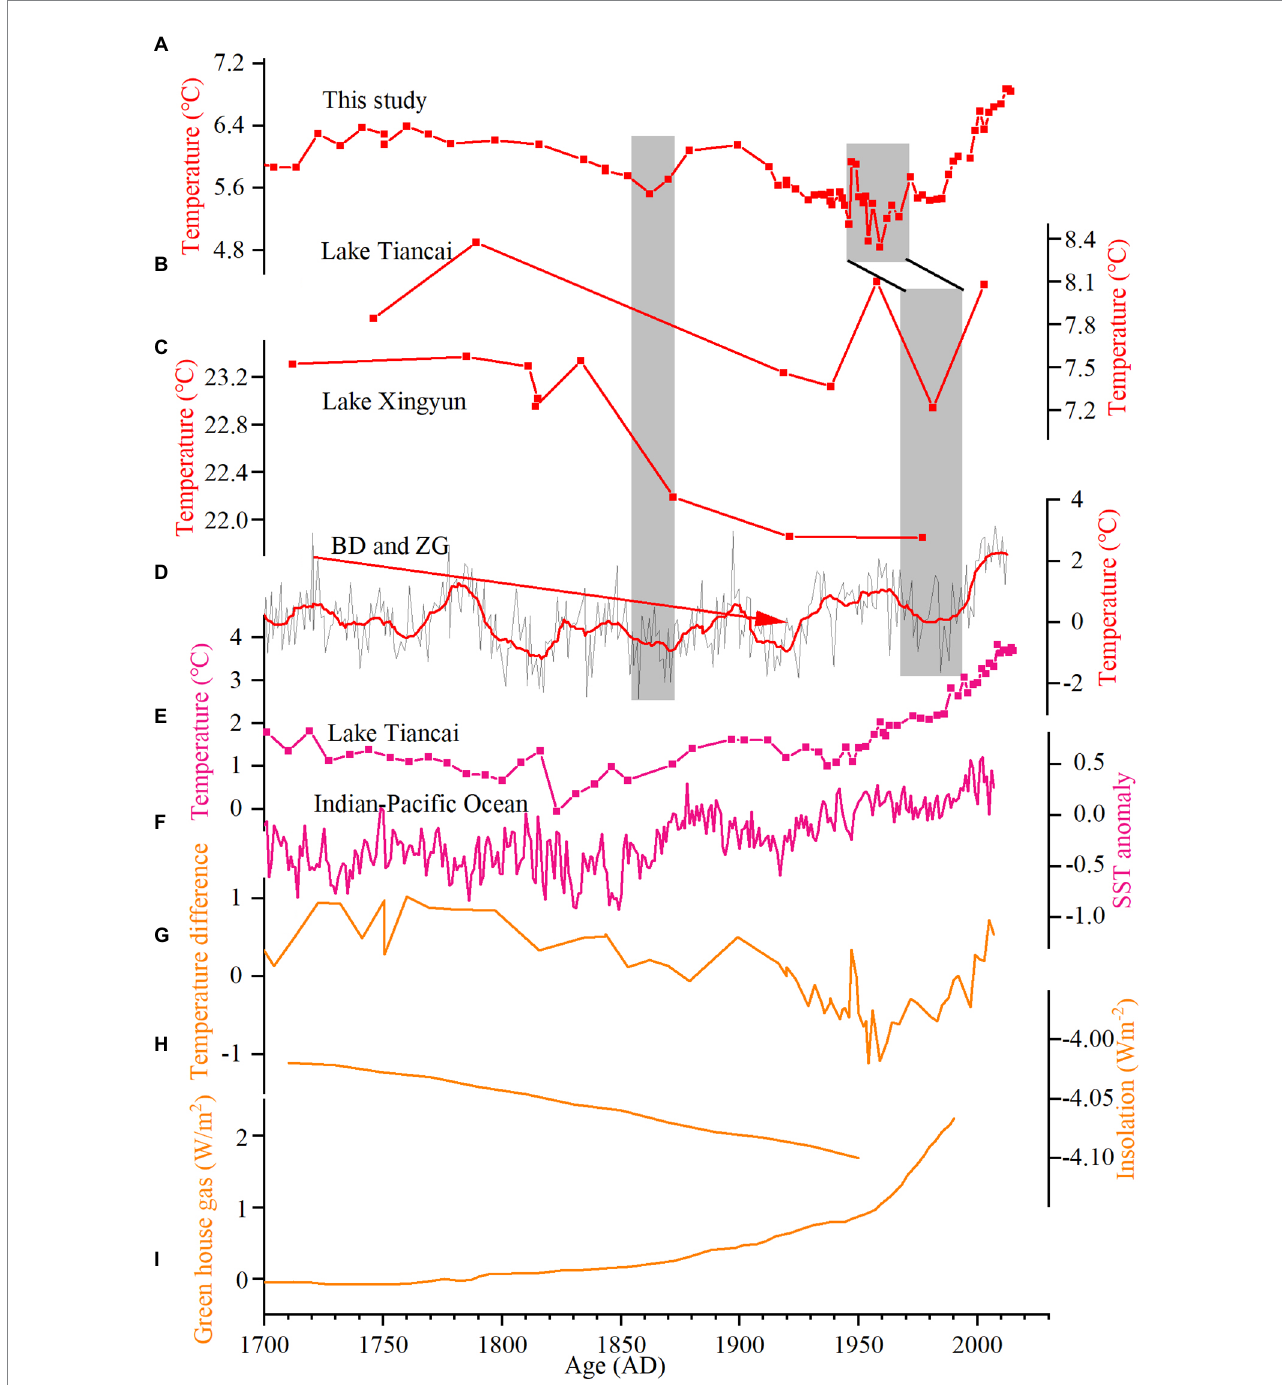
FIGURE 3 Comparison with regional temperature records and driving mechanisms. (A) Quantitative temperature reconstruction from Lake Cuoqia in this study. The gray shadows indicate period of low temperature. (B) Quantitative mean July temperature reconstruction based on subfossil chironomids from Lake Tiancai (Zhang et al., 2017). (C) Pollen-based mean July temperature record from Lake Xingyun (Wu et al., 2018). (D) The Apr-Sep mean temperature reconstruction using tree ring from Bangda (BD) and Zuogong (ZG) in the southeastern Tibetan Plateau (Duan and Zhang, 2014). (E) Quantitative mean annual air temperature using brGDGTs from Lake Tiancai (Feng et al., 2019). (F) The temperature reconstruction of Indian-Pacific Ocean based on coral records (Tierney et al., 2015). (G) Temperature difference between our reconstructed temperature anomaly and SST from Indian-Pacific Ocean (Tierney et al., 2015). (H) Warm-season insolation anomaly at 26 ° N (Laskar et al., 2004). (I) GHG-driven forcing (Crowley, 2000). (For interpretation of the references to color in this figure legend, the reader is referred to the web version of this